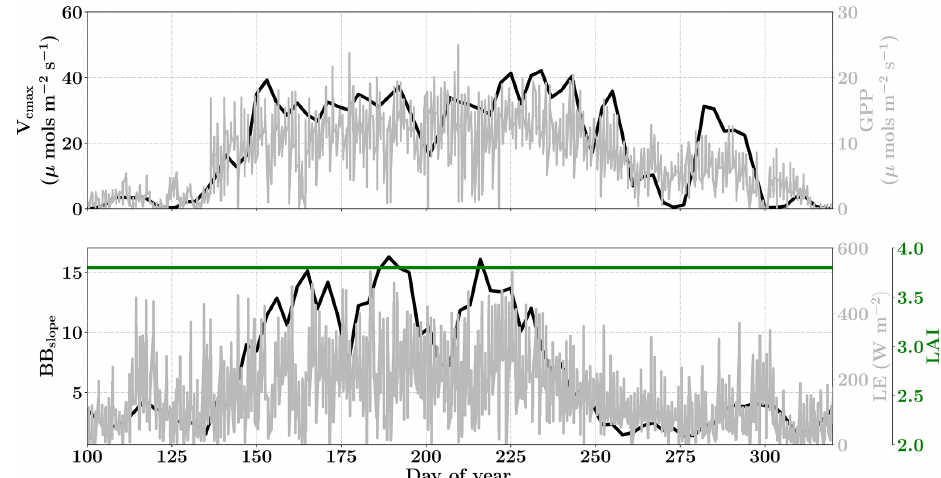
Figure 13. Figure showing the seasonal variability in retrieved parameter values of V cmax , BB slope and LAI for the Niwot Ridge site using a 3-day moving window inversion approach for the year 2010. The actual points in the time series (grey lines) of the GPP and LE fluxes used as the target observations ( Y ) for the moving window inversion approach are shown in the background. The results show reasonable trends in the retrieved parameters along with their sensitivity to GPP and LE fluxes across the growing season.